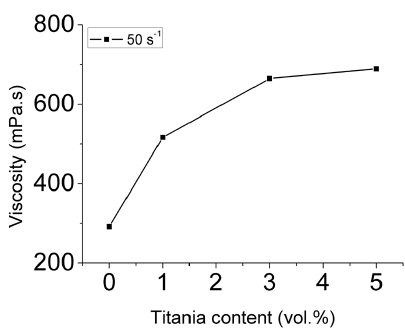
Figure 3: Apparent viscosity of the suspensions of Ni-TiO with different